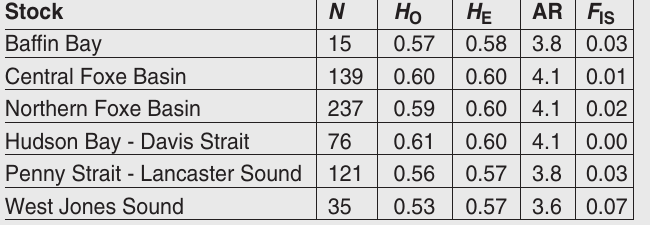
Penny Strait - Lancaster Sound